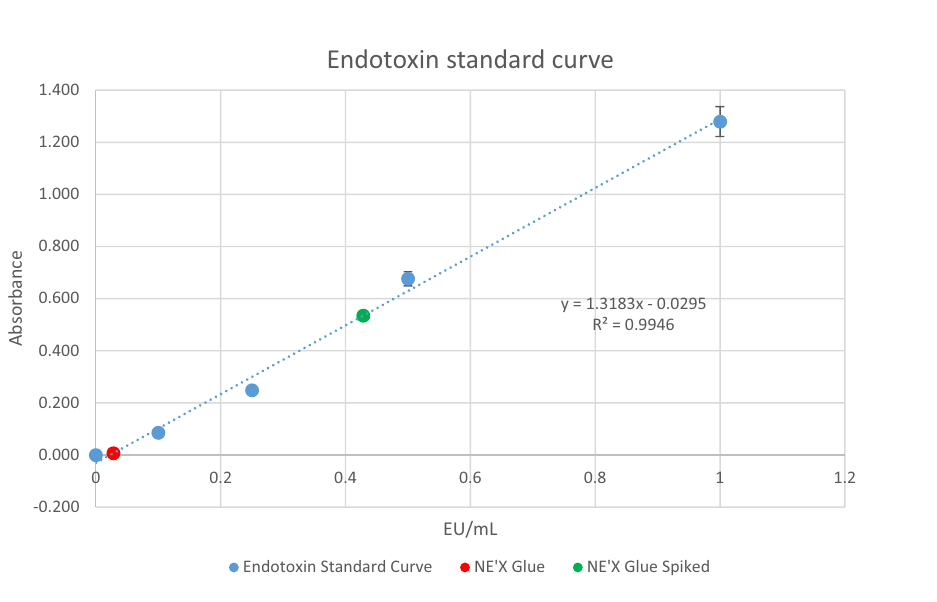
Figure 3. Endotoxins concentration standard curve and